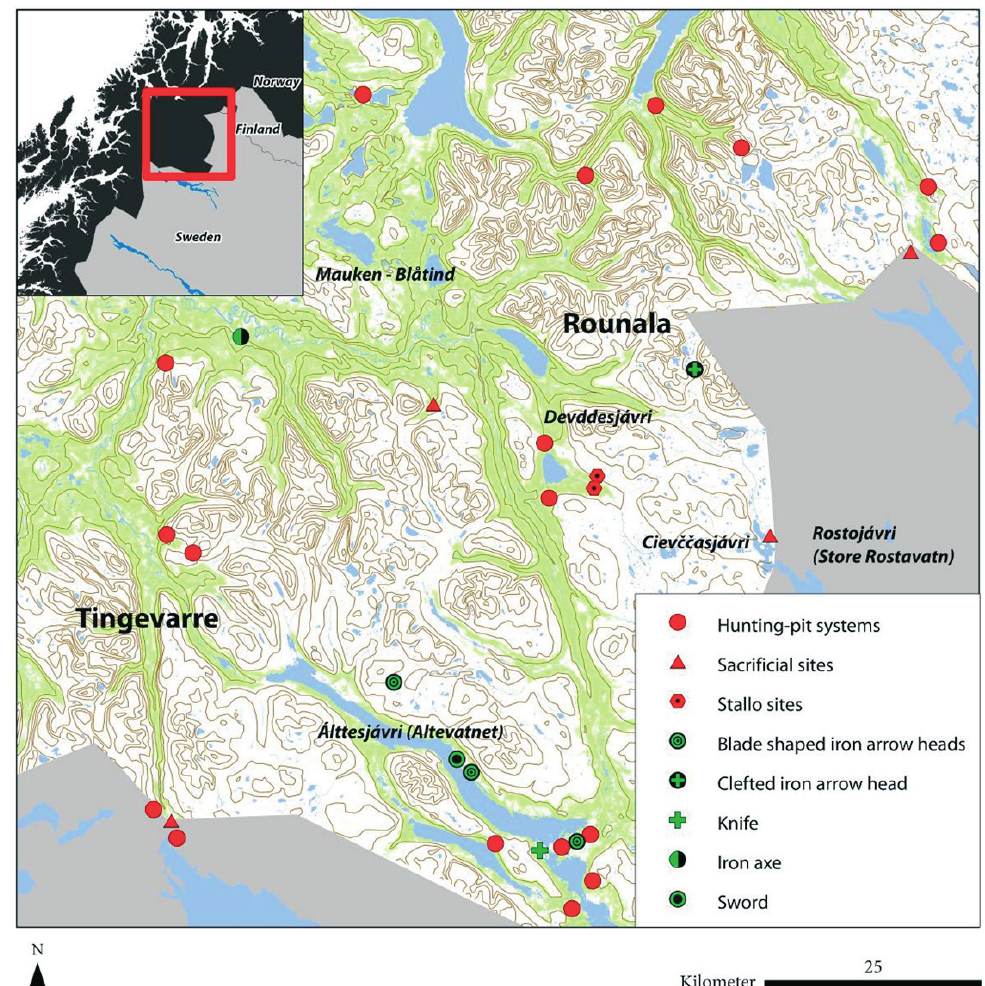
Fig. 2. Interior of Troms; marked with archaeological finds from the Merovingian period, the the Viking Age and early Medieval times (about AD 600 to 1300), as well as pitfall systems in the interior, some of which are dated to the period between 3500 BC to AD 1600 (Klaussen, 2008:39, 47). Illustration: Ingrid Sommerseth and Johan Eilertsen